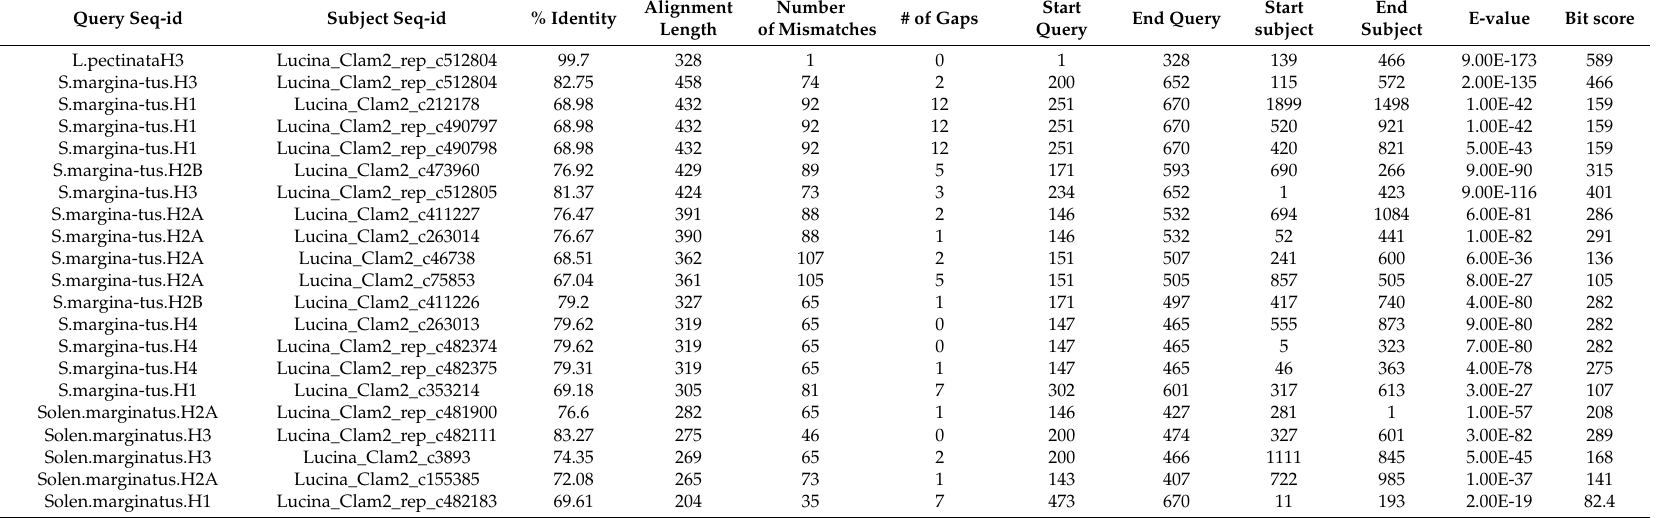
Table 2. Histone Nucleotide sequences identified from the BLASTN searches using the Lucina pectinata partial Histone H3 sequence and histone nucleotide sequences from the clam Solen marginatus as queries against the L. pectinata genome